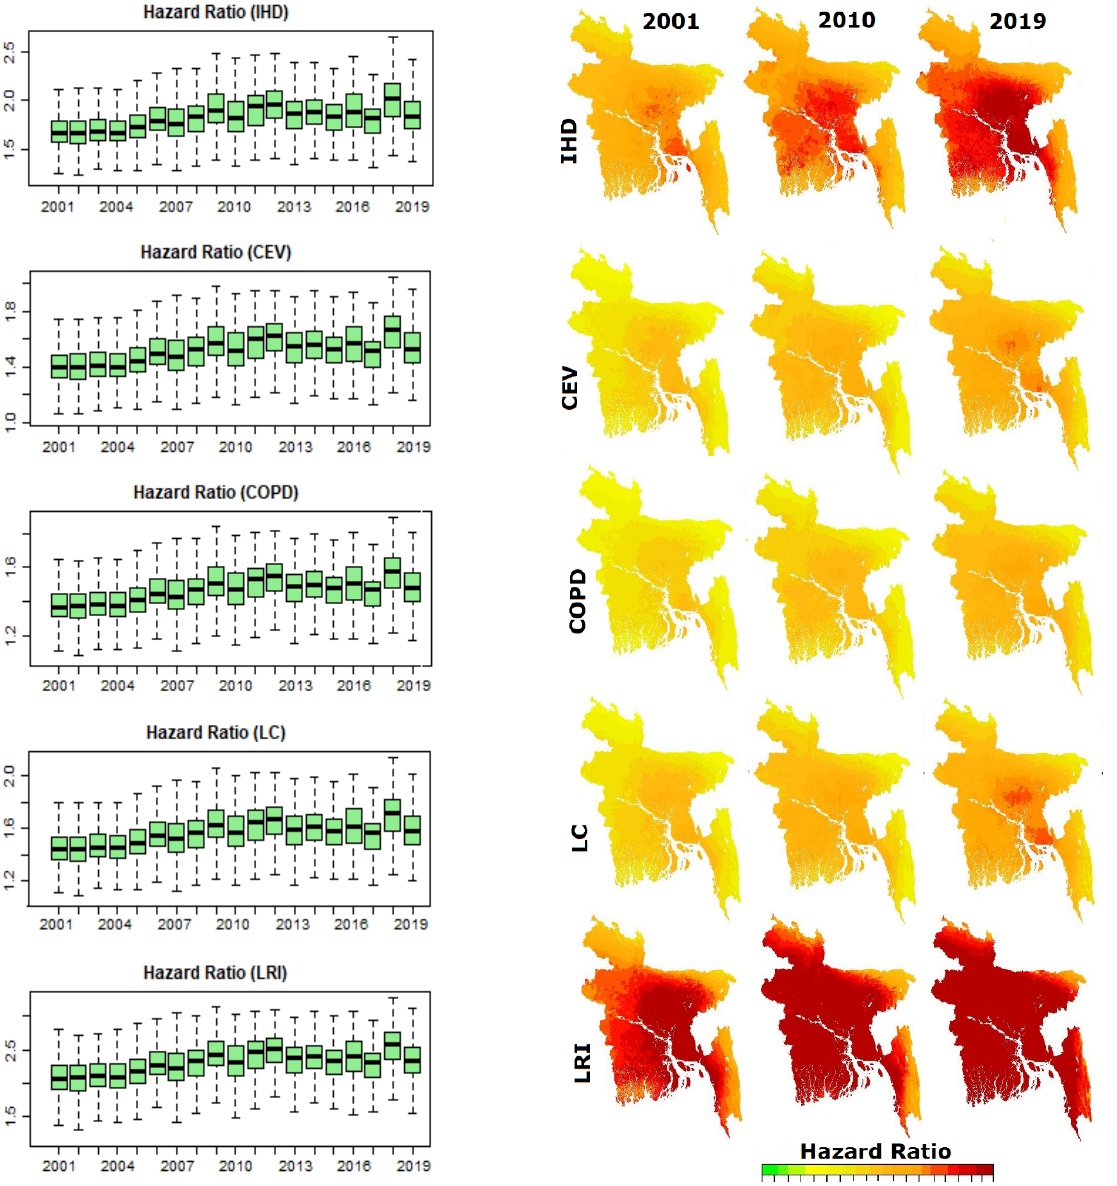
Figure 7 . Spatial distribution of hazard ratio (HR) of selected diseases due to PM 2.5 for three representative